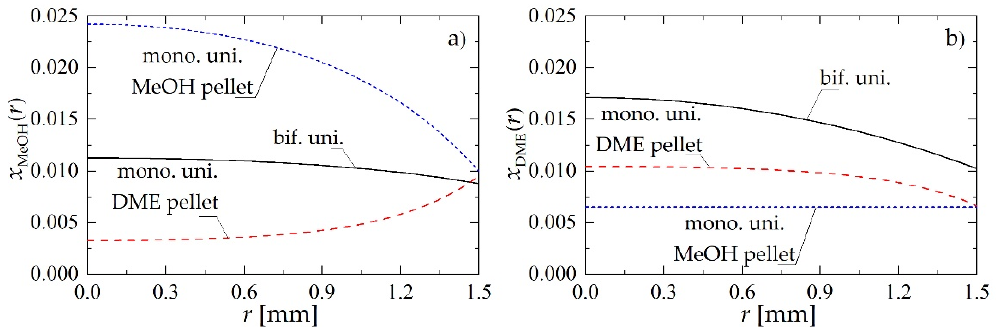
Figure 4. Molar fraction radial profiles within bifunctional catalyst pellet for R p = 1.5 mm and u in = 0.05 m·s −1 : ( a ) H 2 O molar fraction at a distance of z = 0.5 m from the reactor inlet; ( b ) H 2 O molar fraction at the reactor outlet.